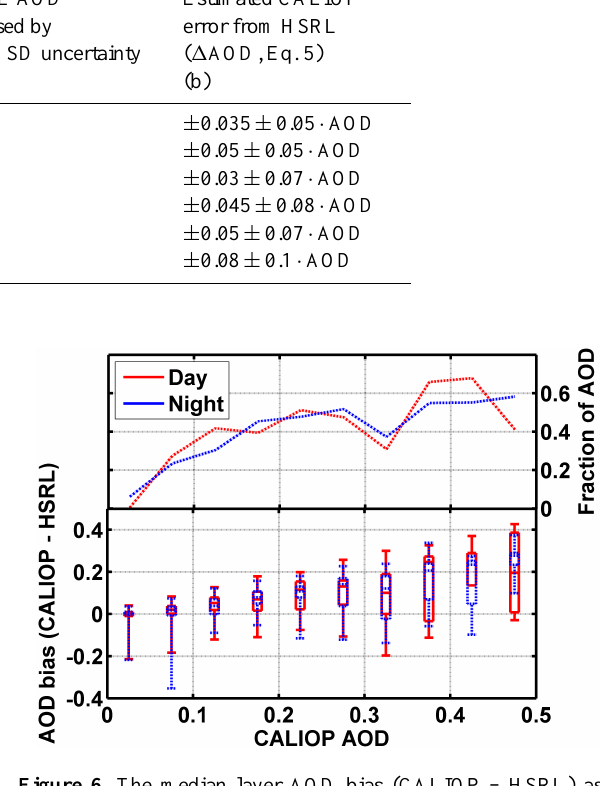
Figure 6. The median layer AOD bias (CALIOP – HSRL) as a function of CALIOP layer AOD (bottom panel) for both day (red) and night (blue) measurements. The boxes are the quartiles and the whiskers the minimum/maximum of each bin. The dash-dot lines represent the median bias as a fraction of the AOD bin (top